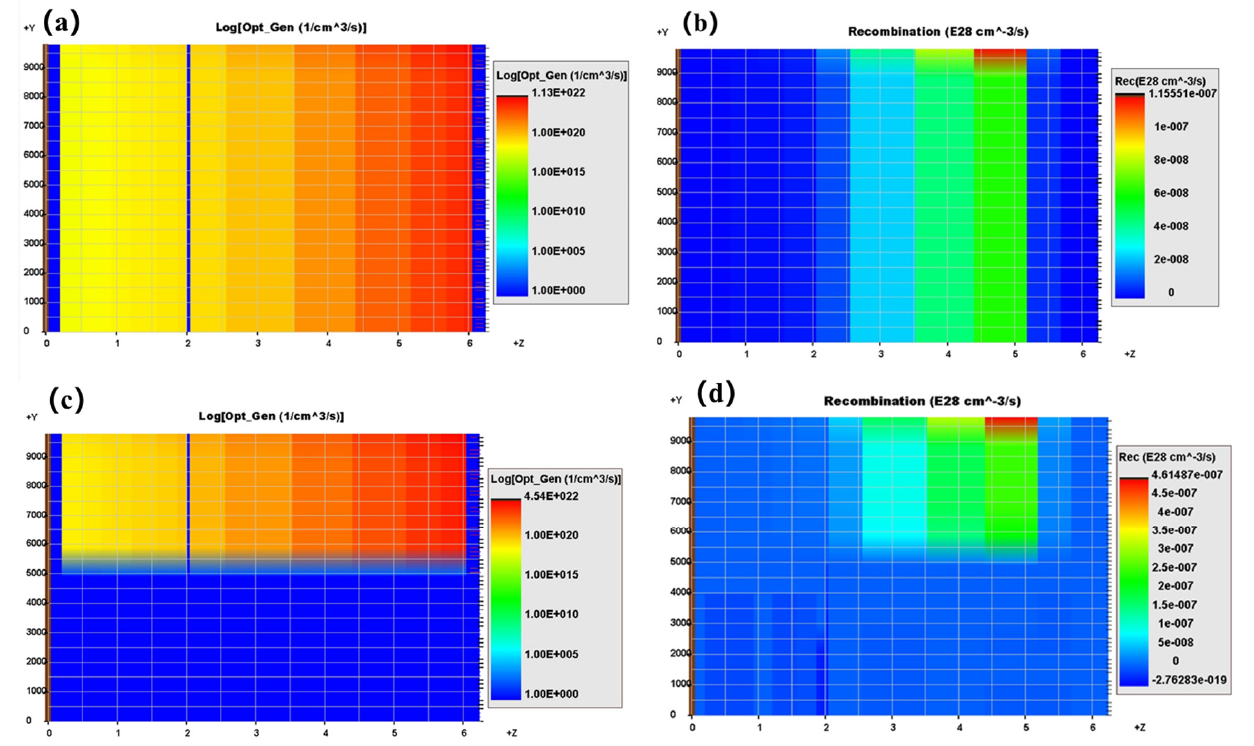
Figure 10. ( a ) The photogenerated carrier rate under 100% area illumination; ( b ) Carrier recombina- tion rate distribution under 100% area illumination; ( c ) Photogenerated carrier rate under 50% area illumination; ( d ) Carrier recombination rate under 50% area illumination.